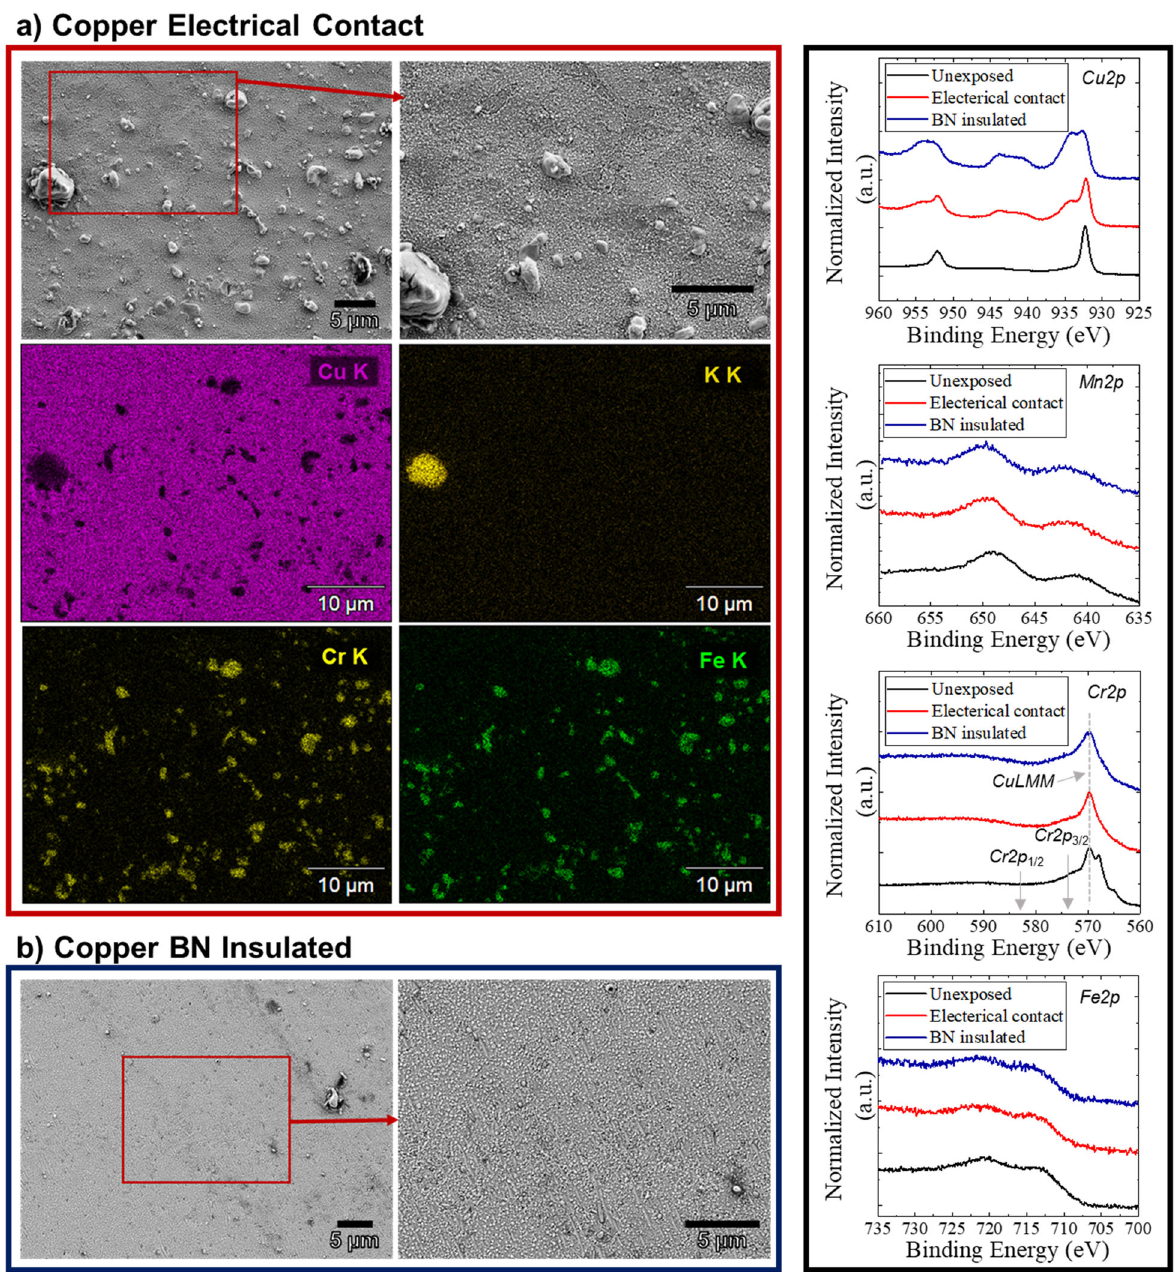
Fig. 5 SEM and XPS analysis of copper samples. a Planar SEM images with EDS maps of the copper sample in electrical contact with the 316L corrosion capsule. b Planar SEM images of the copper sample electrically insulated from the 316L corrosion capsule. c XPS binding energy plots from both exposed copper samples were plotted with the unexposed copper sample for